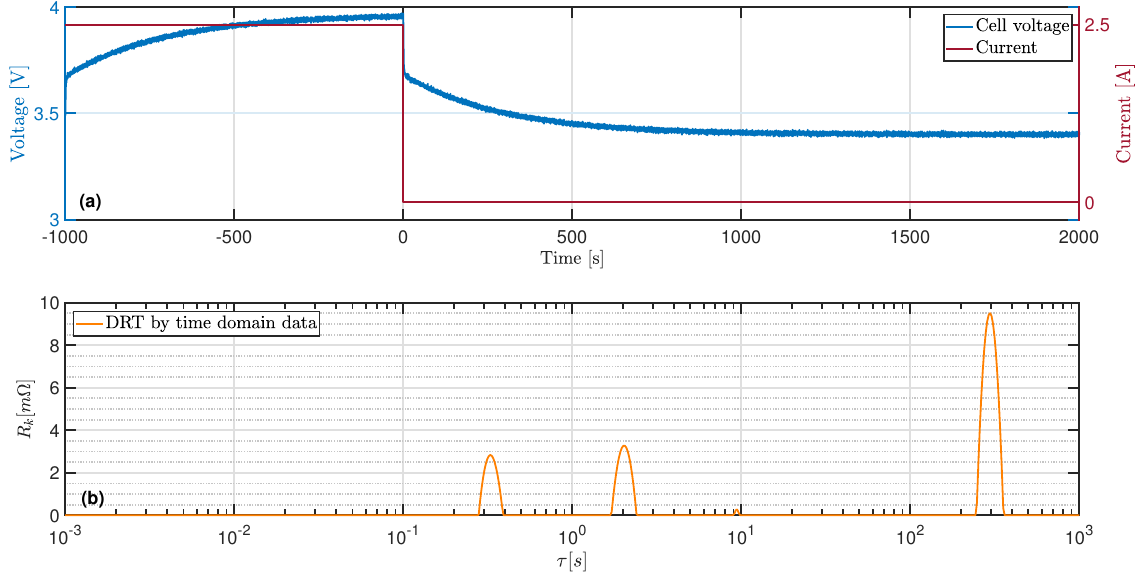
Figure 2. ( a ) Simulated cell voltage of a LIB during a pulse test. ( b ) DRT derived from the voltage